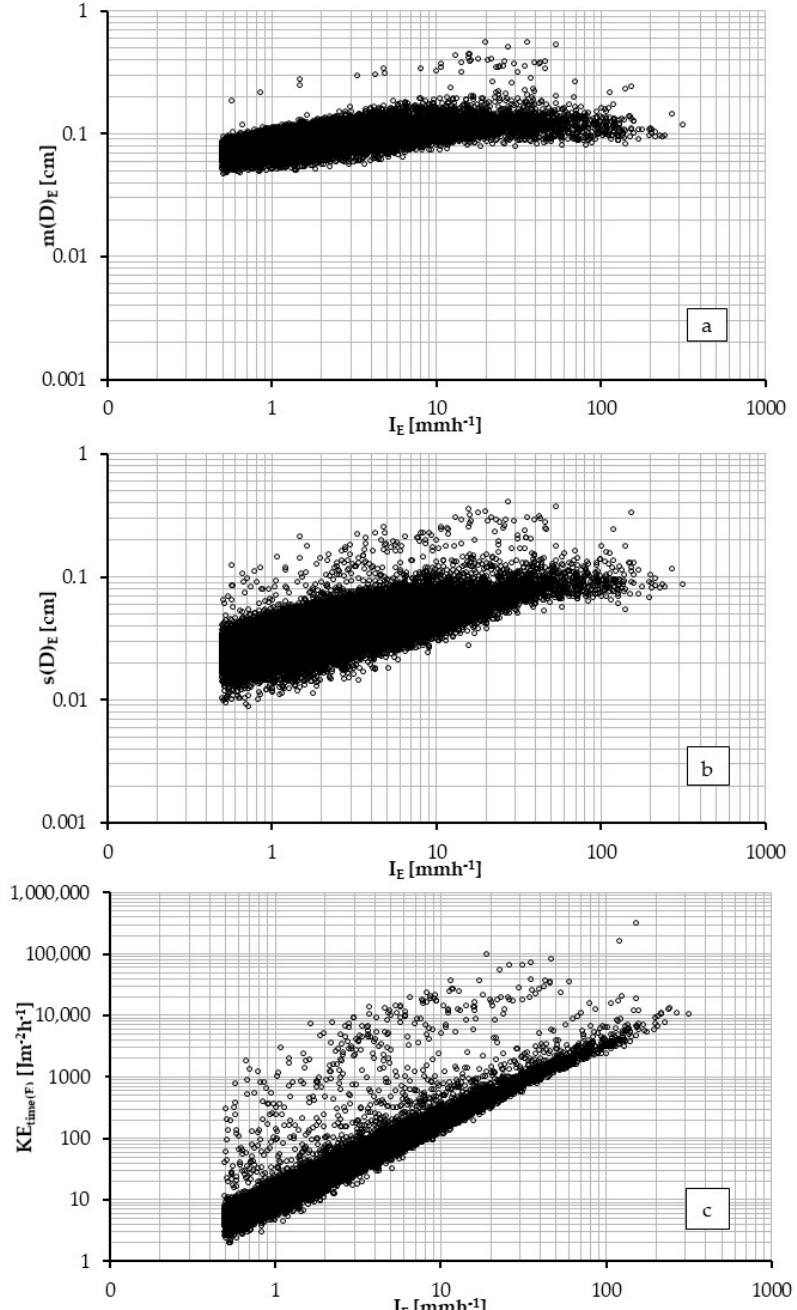
Figure 6. The mean diameter m(D) E and standard deviation s(D) E of drop size distributions (DSDs) are represented against the rainfall rate I E ( a and b , respectively). Empirical kinetic energy expenditure (i.e., KE time(E) ) against rainfall intensity ( c ).